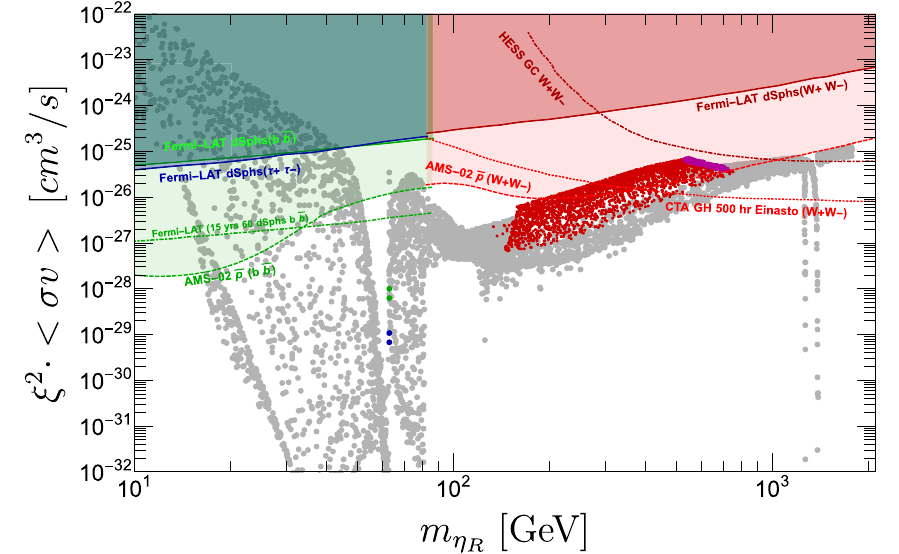
Fig. 6 η R annihilation cross section for annihilations into b ¯ b (green), H.E.S.S. using GC data [48]. The green and red dashed lines denote τ + τ − (blue) and W + W − (magenta when η current 95% C.L. constraints derived from the antiproton and B/C data R makes all the dark matter, of AMS-02 [50]. For comparison, we also show sensitivity projections red when it comprises a subdominant fraction) final states. The green, for Fermi-LAT ( b ¯ b channel, assuming 60 dSphs and 15 years of data) blue and red plain lines refer to the corresponding 95% C.L. upper lim- [76] and for CTA (looking at the galactic halo, W + W − channel) its currently set by Fermi-LAT γ -ray data from dSphs [47]. The dark red dot-dashed curve is the current 95% C.L. upper limit obtained by